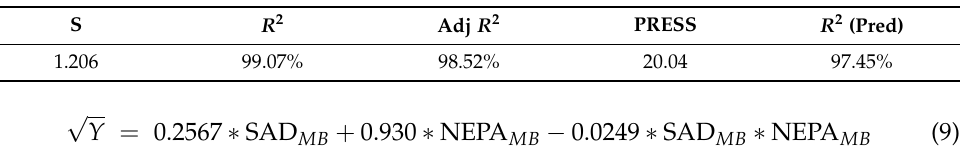
Table 5. Predictive ability and fit of Make breakfast PLSR model.